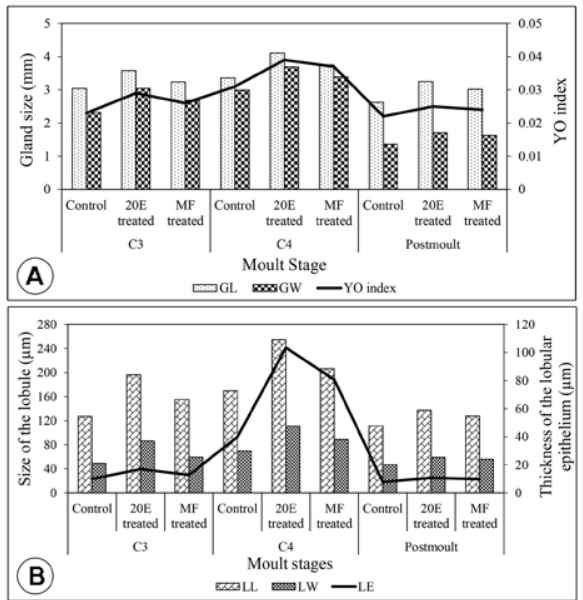
Figure 1. Graph showing the effect of 20E and MF administration on YO index, gland and lobule size and height of the lobular epithelium during late intermoult and early postmoult stages in Travancoriana schirnerae . ( A ) Effect of 20E and MF administration on YO index and gland size. ( B ) Effect of 20E and MF administration on lobule size and height of lobular epithelium. GL: Gland length; GW: Gland width; LL: Lobule length; LW: Lobule width; LE: Thickness of the lobular